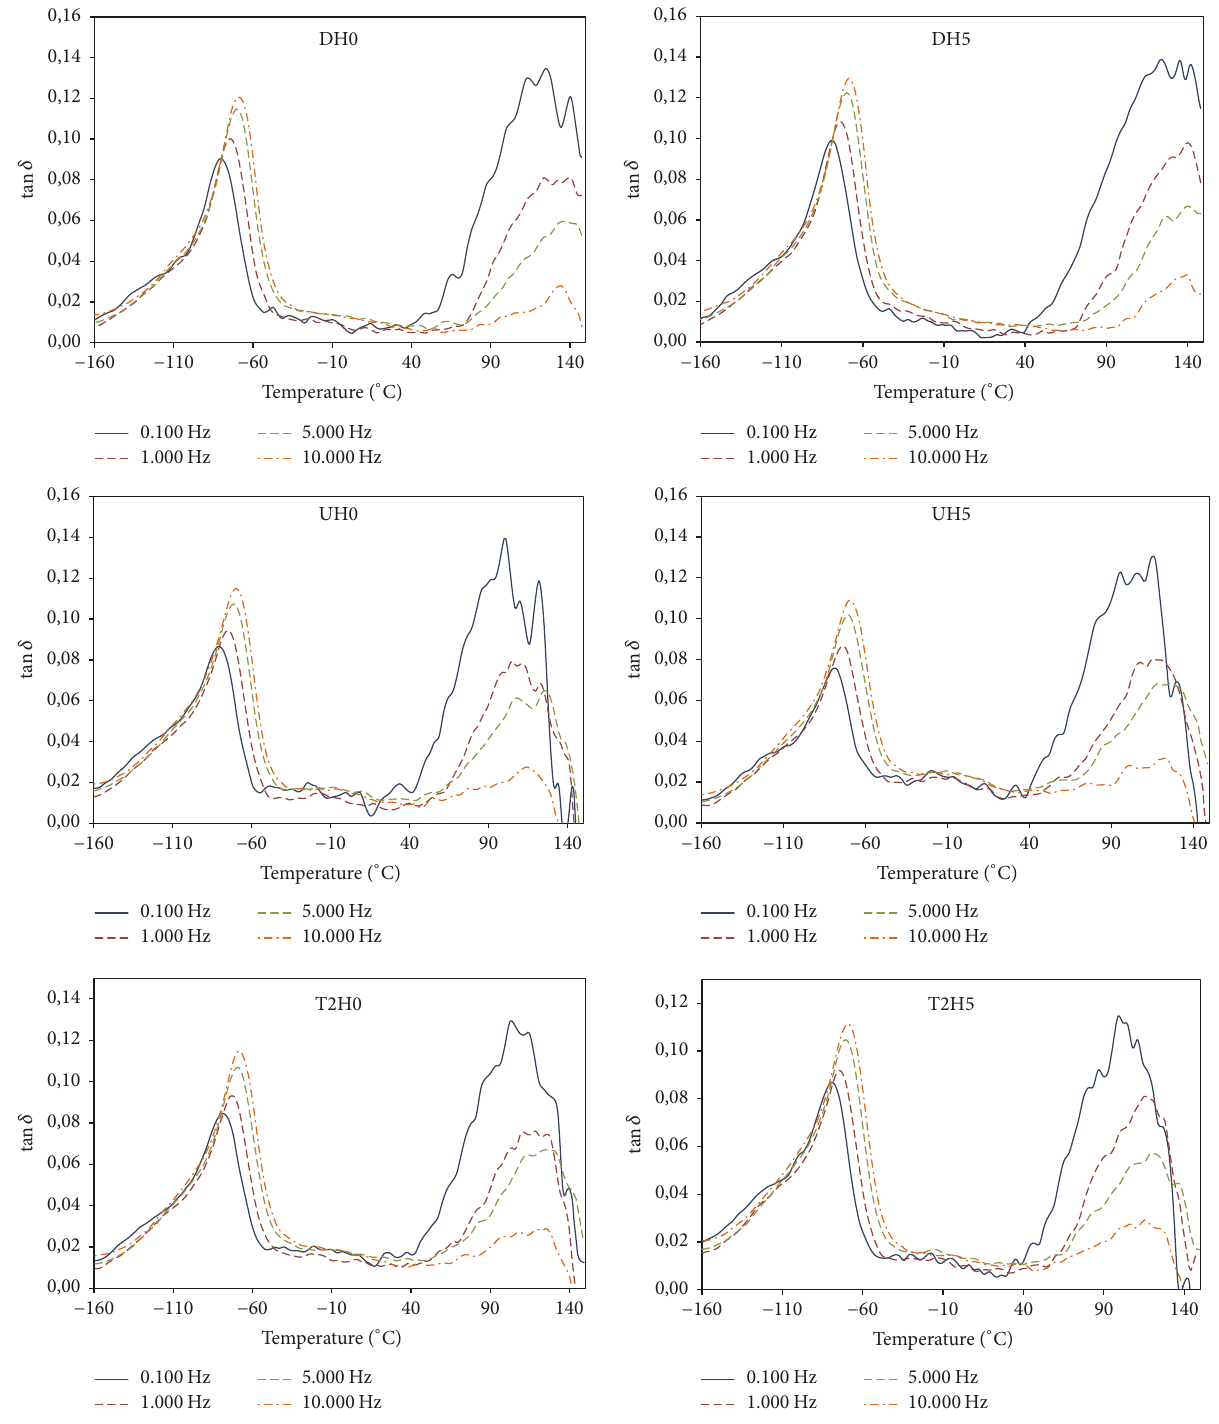
Figure 1: DMA curves for POM and POM/5% HAp nanocomposites: tan 𝛿 versus